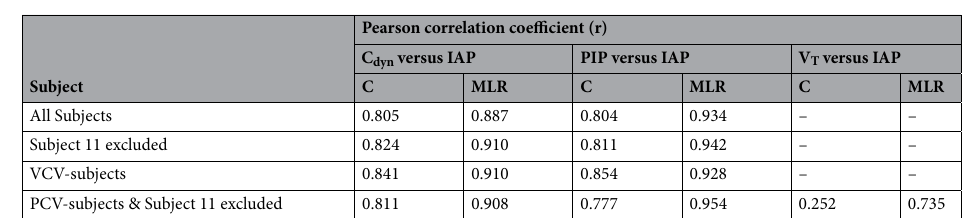
Table 2. Summary of linear correlation results. The listed values represent mean of Pearson’s correlation coefficients (r), where IAP is intra-abdominal pressure, C dyn is dynamic lung compliance, PIP is peak airway pressure, and V T is tidal